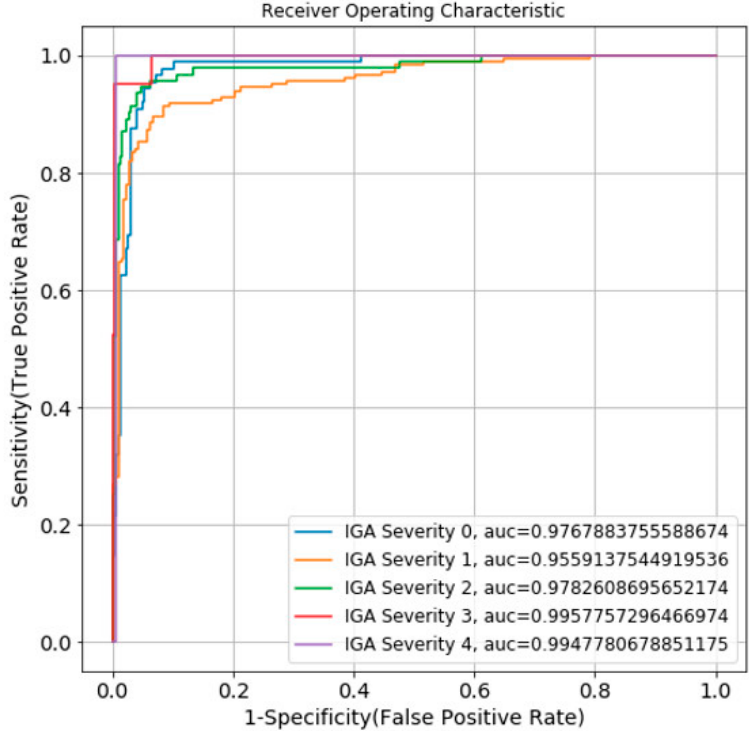
Figure 5. ROC–AUC diagram of the acne severity grading model. Table 5. Precision, recall, F1 score, and accuracy of acne grading model.